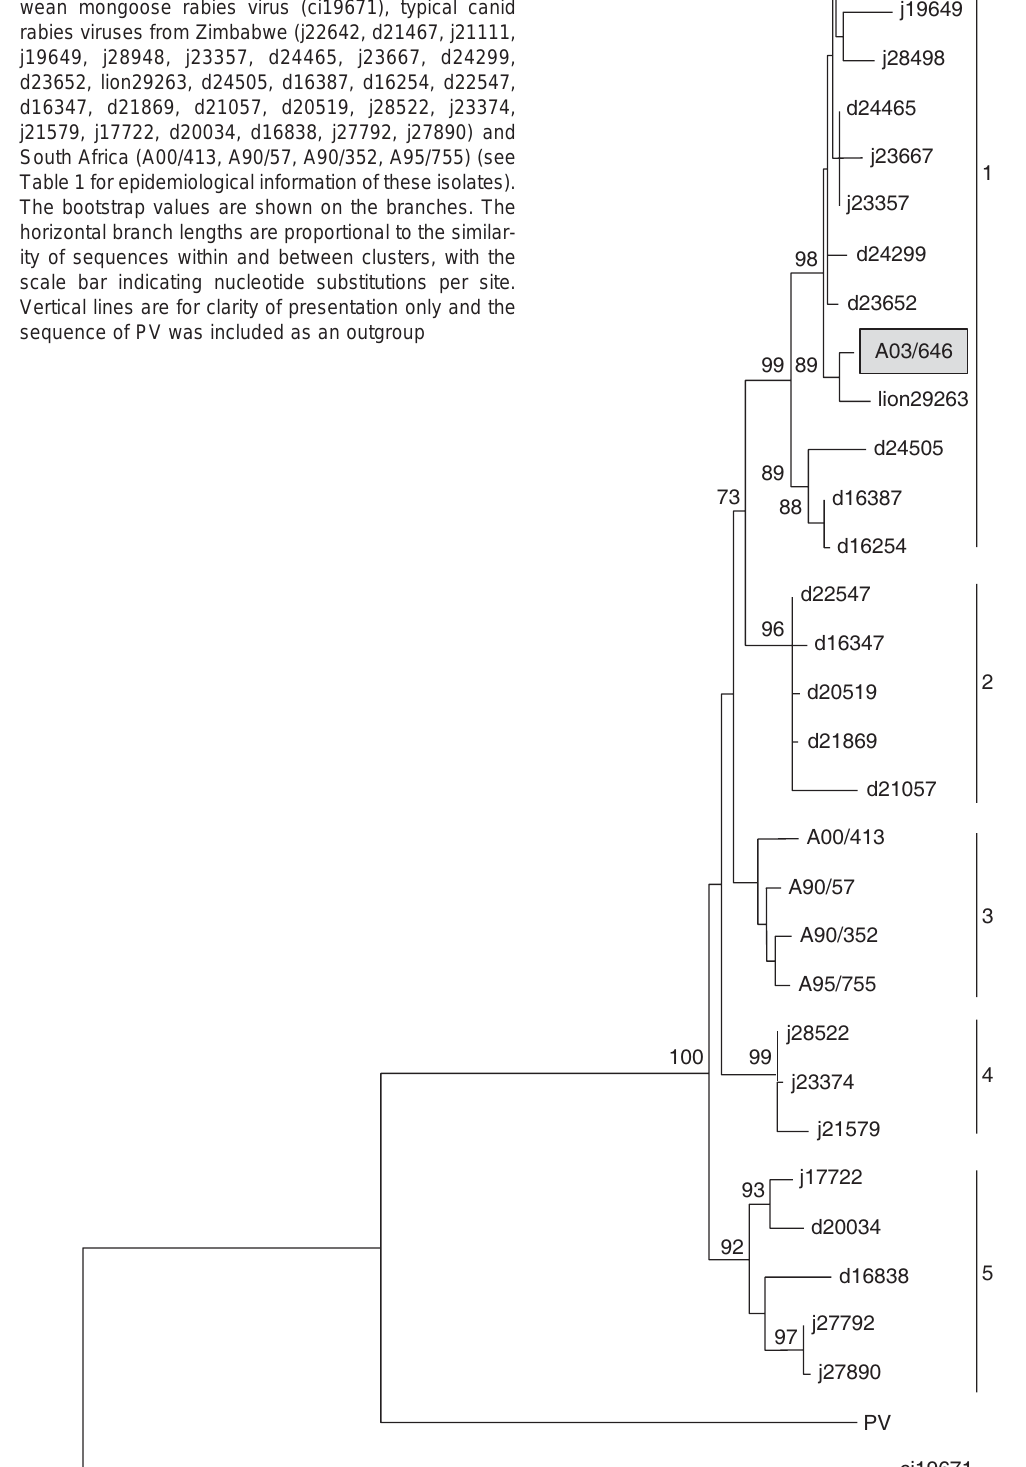
FIG. 2 Neighbour Joining tree showing the phylogenetic posi- tion of the equine rabies virus (A03/646) described in the paper. The inferred phylogeny is based on sequence comparison of the cytoplasmic domain of the glycopro- tein and the G-L intergenic regions of the virus isolates. Included in the phylogenetic tree are: a typical